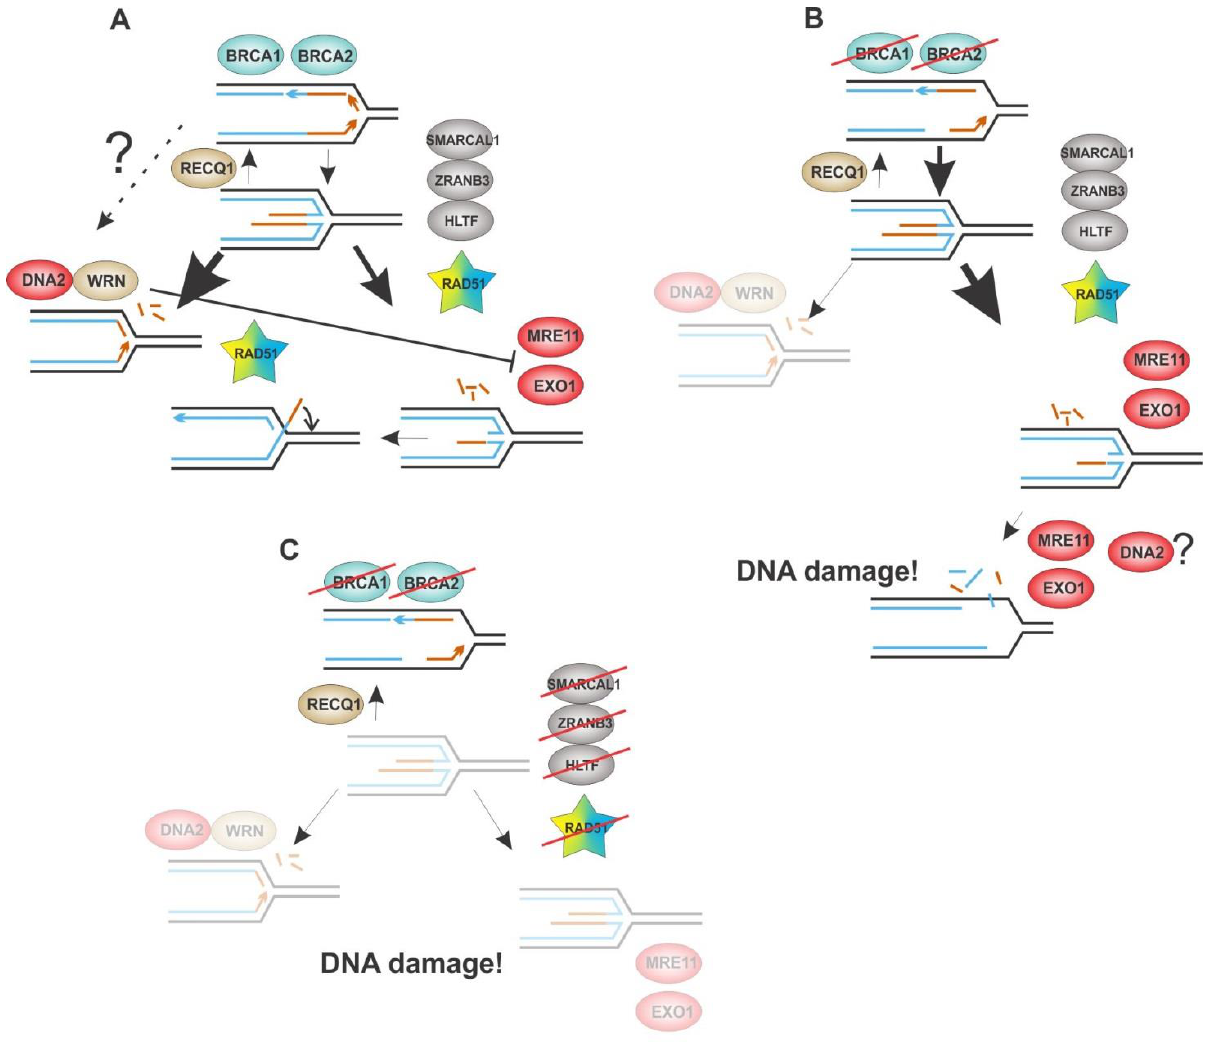
FIGURE 4: A model for two interlinked branches of fork resection and their alterations upon mutational loss of the involved proteins. In a wild type cell the MRE11, EXO1 branch may be less prevalent than the DNA2/WRN branch, depending on the cell background. An inhibitory feedback from WRN to MRE11 may contribute to this arrangement. Fork resection may be limited by restorative branch migration of the fork junction, or reannealing of the 3’ overhang in a D-loop-like strand exchange (A) . In BRCA1 or BRCA2-defective cells, the MRE11, EXO1 branch dominates and WRN is no longer a contributor. Fork resection proceeds beyond the four-way junction, either directly, or via cycles of reversal/resection, leading to DNA breakage either directly or via segregation of under-replicated DNA (B) . Inhibition of fork reversal suppresses fork resection but also decreases stalled fork stability and ability to resume replication. DNA damage may result from fork col- lapse and segregation of under-replicated DNA and is exacerbated by BRCA1 or BRCA2 deficiency (C) . Faded areas in the cartoon indicate pathway inactivity. See text of the sections “RAD51 versus the nucleases: reversal, protection, resection?” and “The nuclease crosstalk and the curious case of WRN” for a detailed